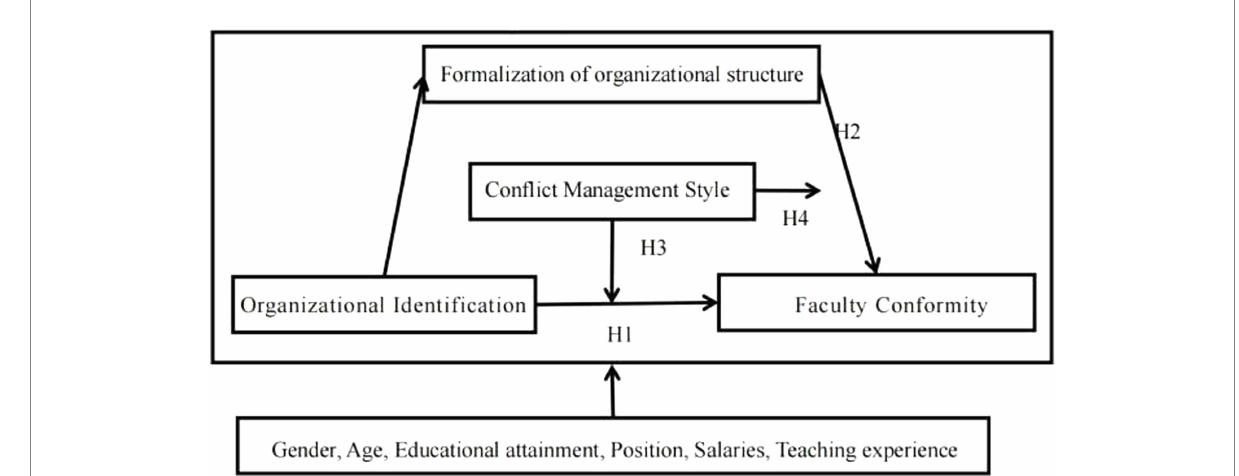
FIGURE 1 Research